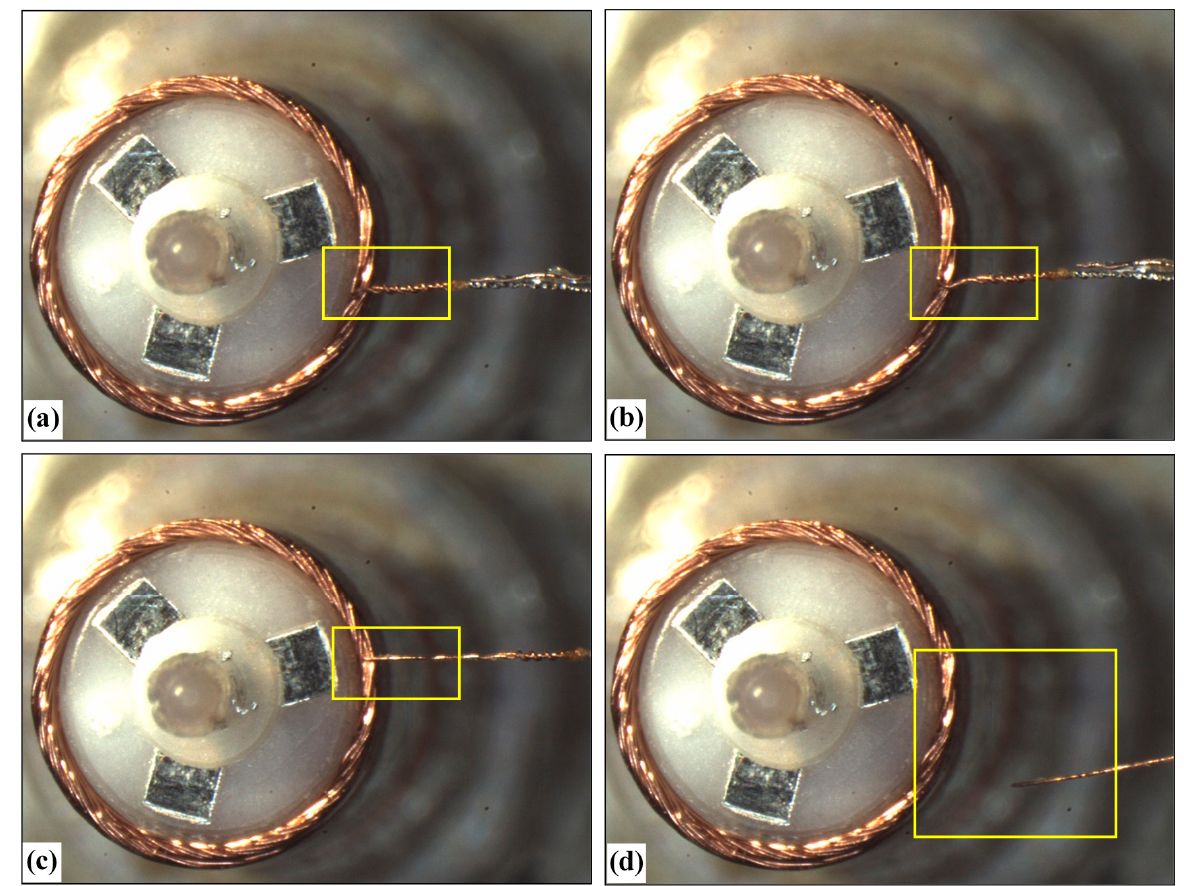
Figure 14. The measurement process of the maximum pulling force on wires: ( a ) Status before applying pulling force; ( b ) Status in applying pulling force; ( c ) The shape of the wire begins to as pulling force increases; ( d ) The wire is broken under large pulling force.